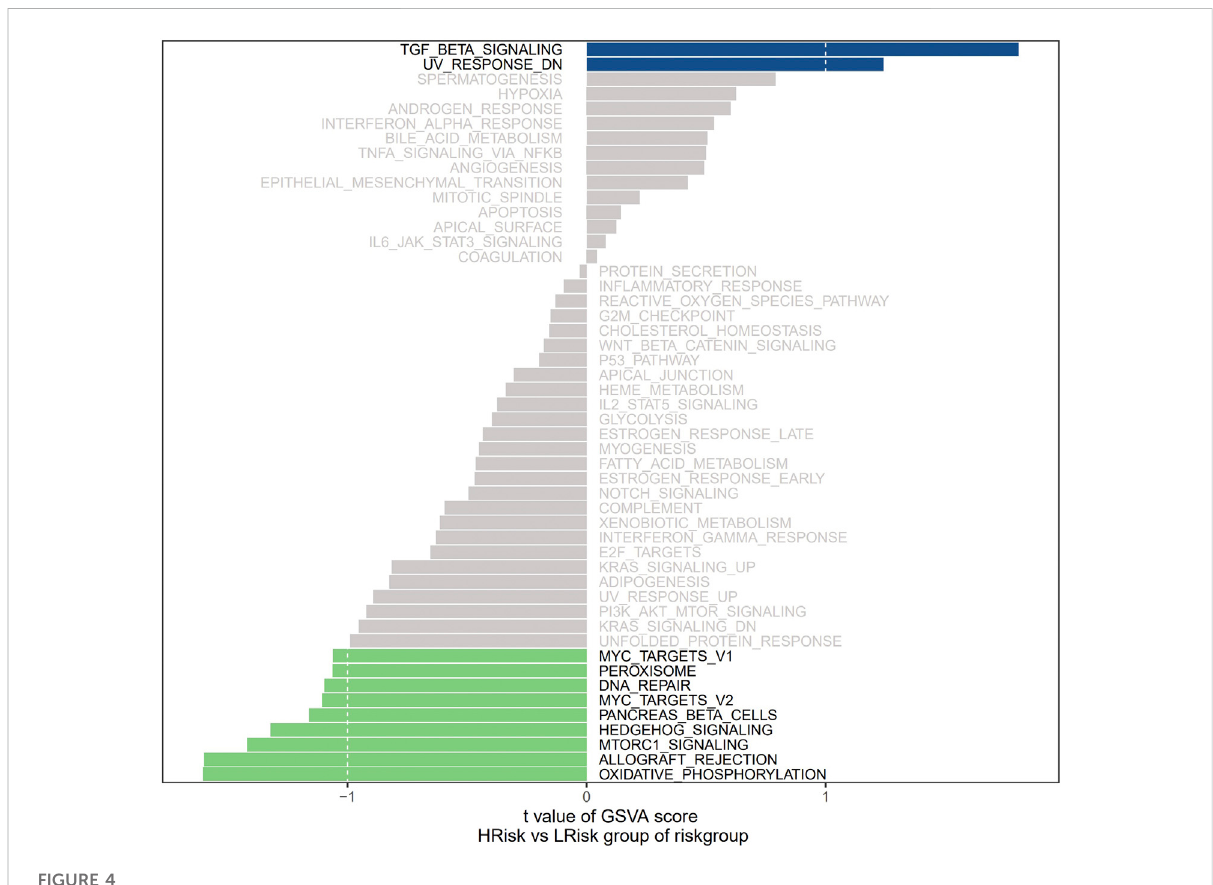
FIGURE 4 GSVA plot of